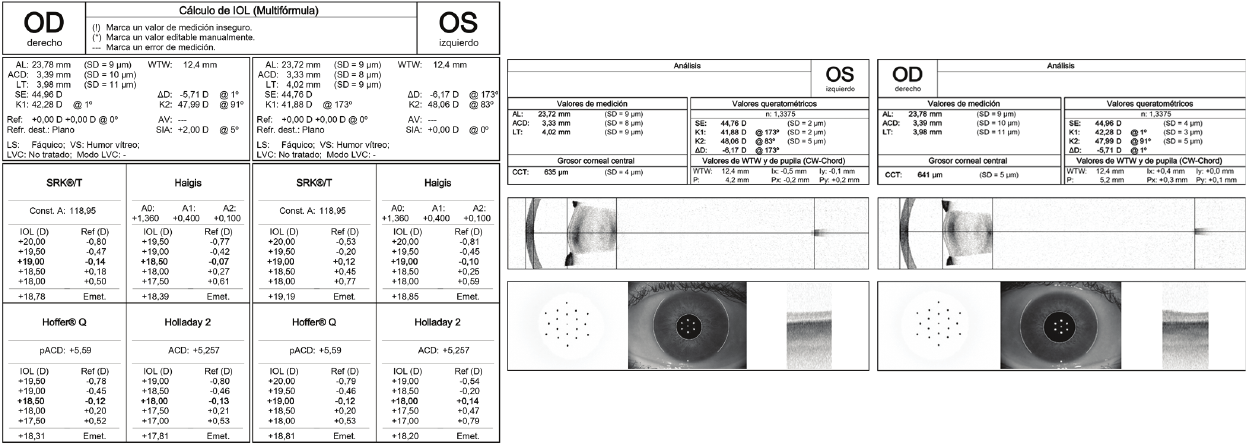
Figure 2. IOLMaster 700 report and a cross-sectional image of both eyes showing the anterior lenticonus projection into the anterior chamber.